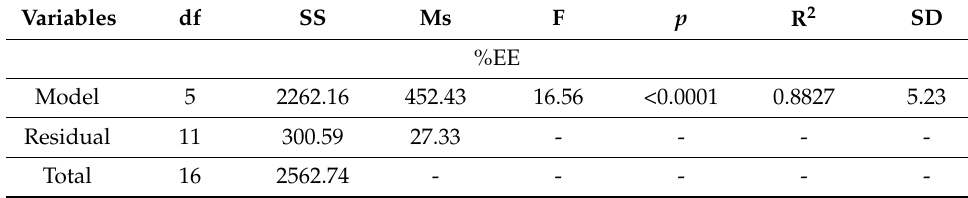
Table 1. Details of response regression and analysis of variance for various